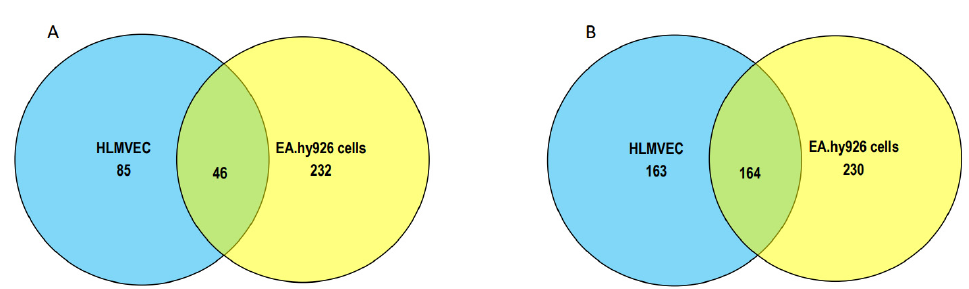
Figure 9. Shared and unique proteins in EA.hy926 cells and HLMVECs modified by 2-ClHDyA. ( A ) Venn diagram of number of proteins specifically modified by 2-ClHDyA in EA.hy926 cells and HLMVECs; ( B ) Venn diagram of number of proteins modified by 2-ClHDyA including those modified by HDyA in EA.hy926 cells and HLMVECs.